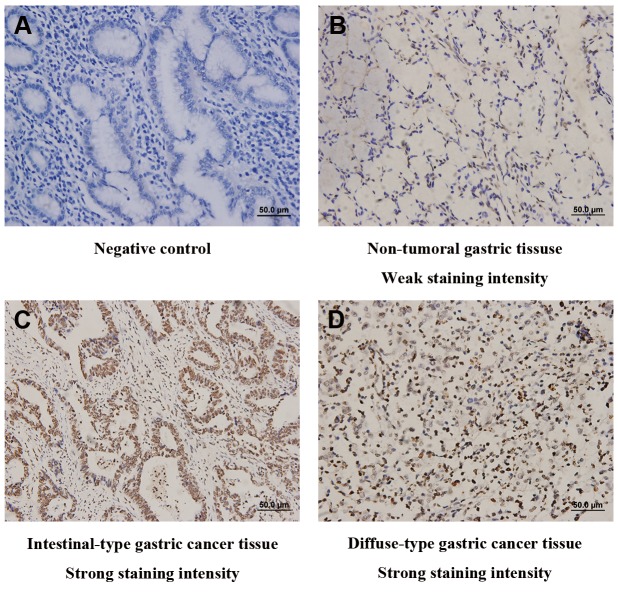
Representative photomicrographs of CXCR4 expression in sections of gastric cancer and non-tumoral tissues.(A) Negative control. (B) Non-tumoral gastric tissue shows week expression of CXCR4. (C) Intestinal-type gastric cancer tissue shows strong expression of CXCR4. (D) Diffuse-type gastric cancer tissue shows strong expression of CXCR4. Scale bar: 50.0 µm.